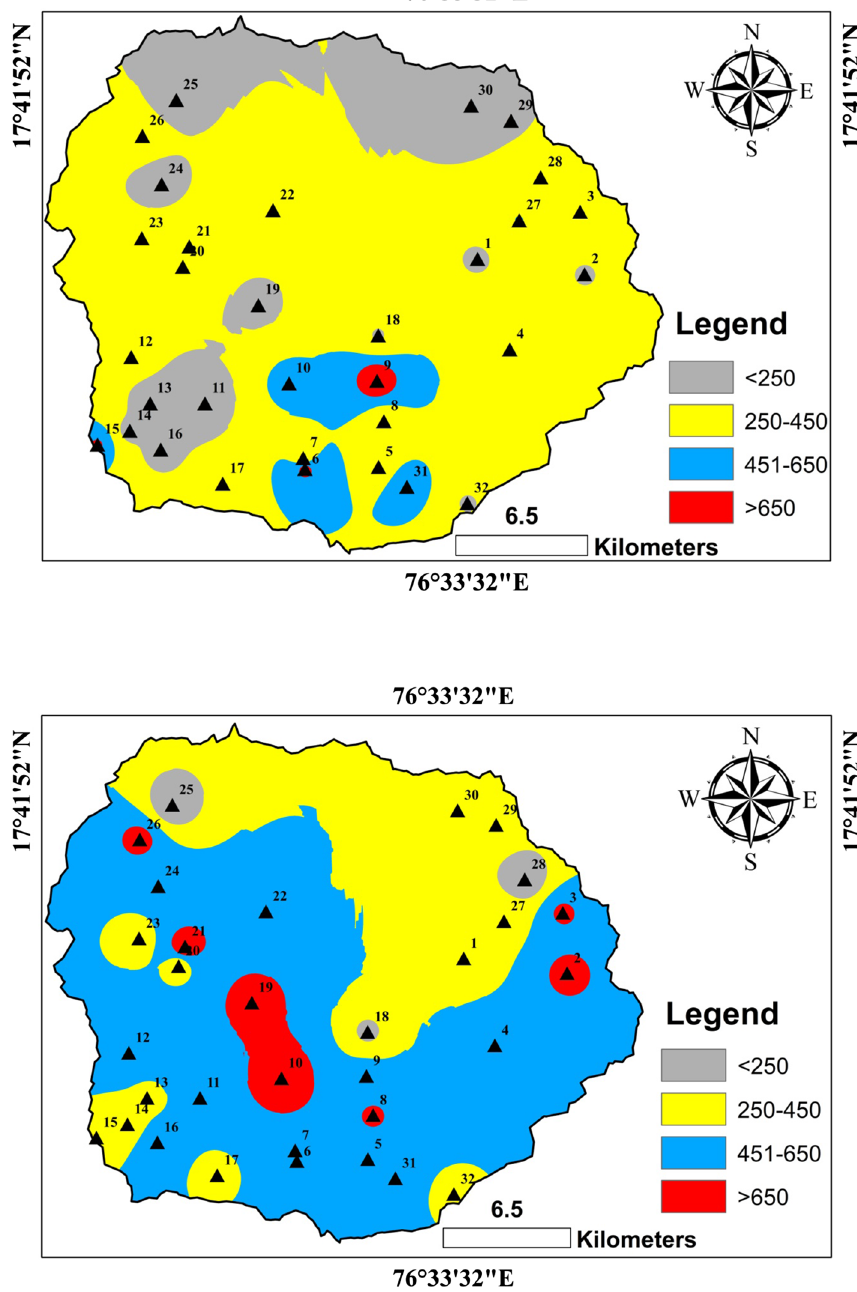
Fig. 6 Geospatial distribution of TDS (pre-monsoon)